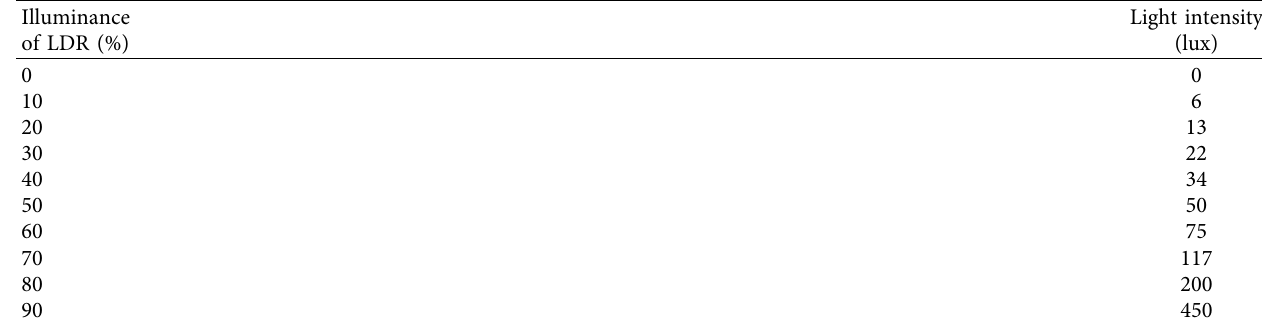
Figure 12: (a) Relation between resistance (K ohm) of light intensity in lux. (b) Relation between resistance (K ohm) of LDR with % illuminance level. Table 5: Relation between lux and LDR % illuminance